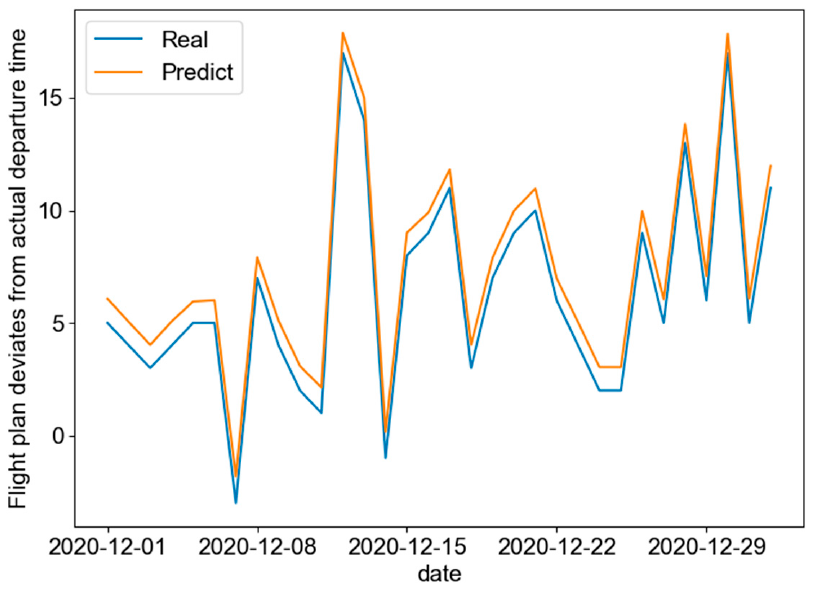
Figure 7. The fitting effect of the validation set after adding the early stopping strategy. Table 5. Evaluation function values corresponding to different flight data. Flight Number